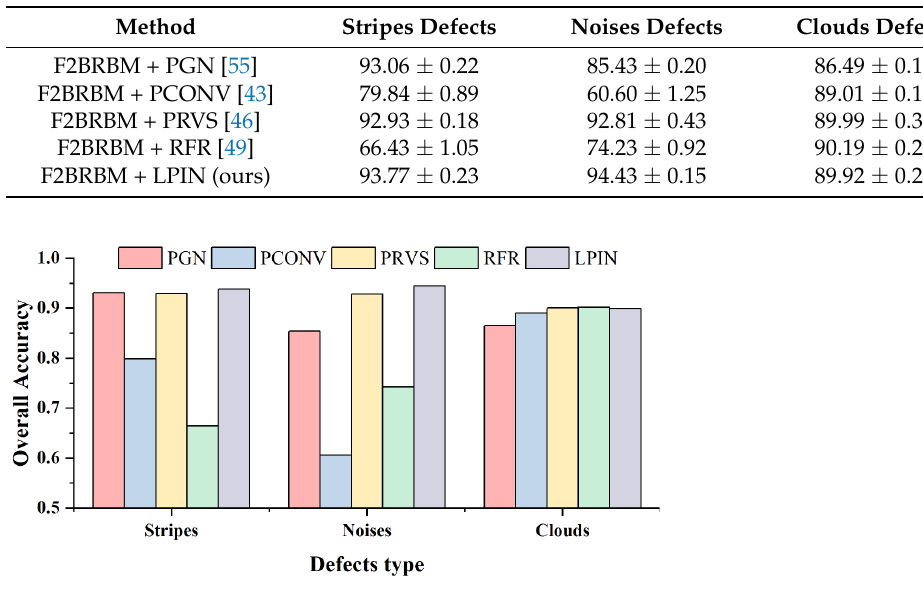
Figure 15. Visualized OA of F2BRBM on images inpainted by different models.